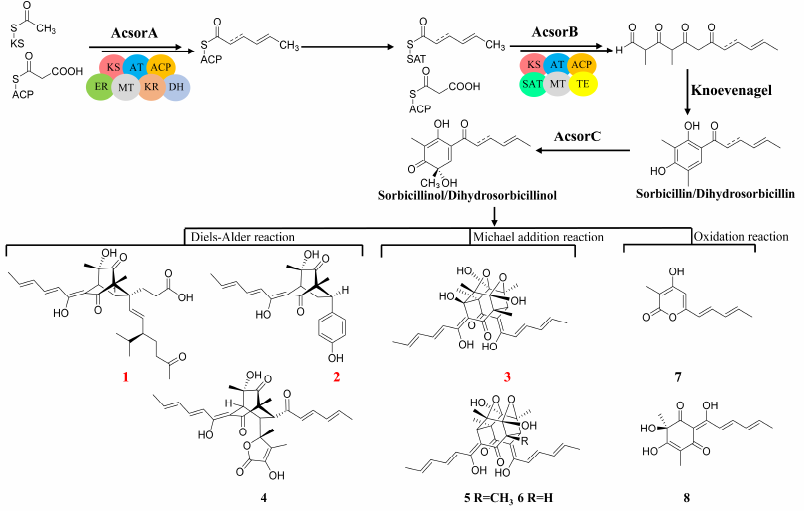
Figure 7. Proposed biosynthetic pathway of compounds 1 – 8.